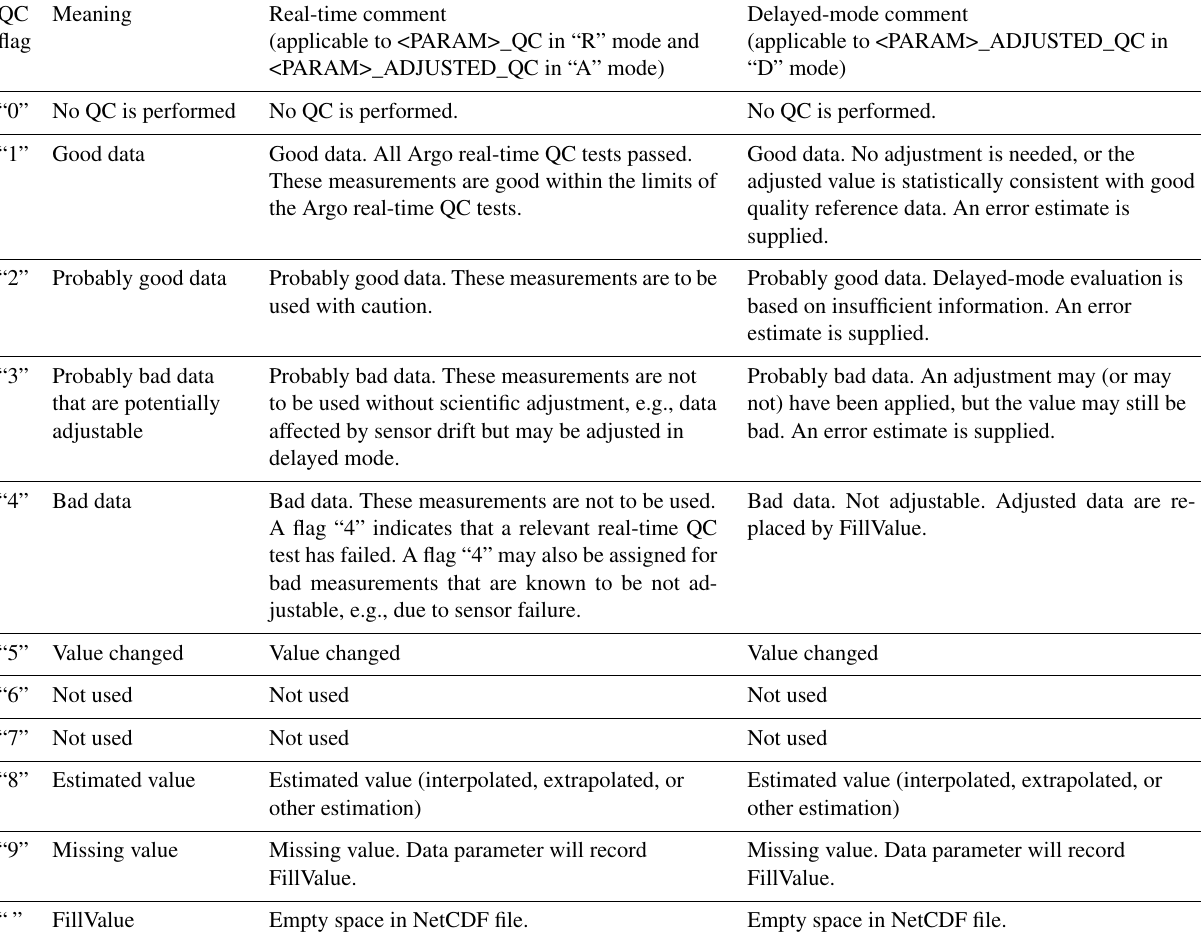
Table 1. Argo quality control (QC) flags. Additional information on these QC flags can be found in “Notes on the Argo QC flags” in the Argo Quality Control Manual for CTD and Trajectory Data (Wong et al., 2022, Sect.